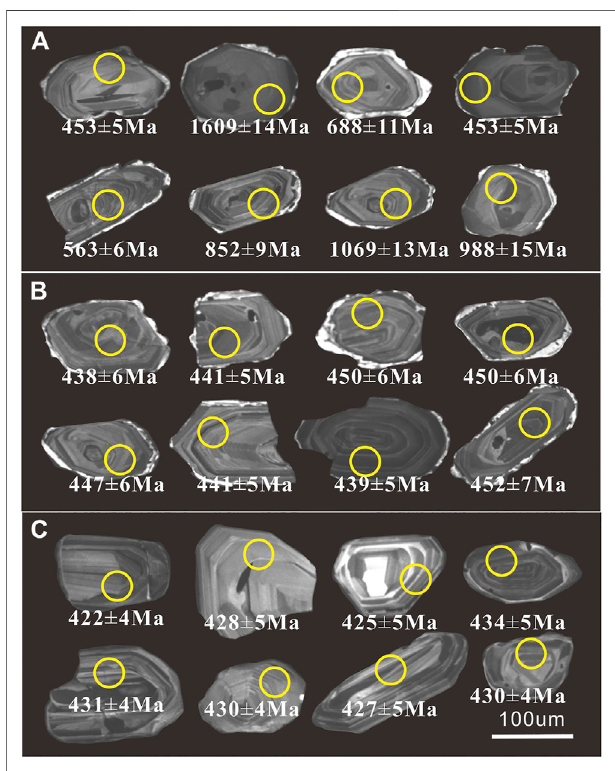
FIGURE 10 | Cathodoluminescence (CL) images of selected zircons from samples EL11 (A) , EL07 (B) , and EL12 (C) at Airgin Sum. Solid circles show positions of LA-ICP-MS analytical sites and ages in